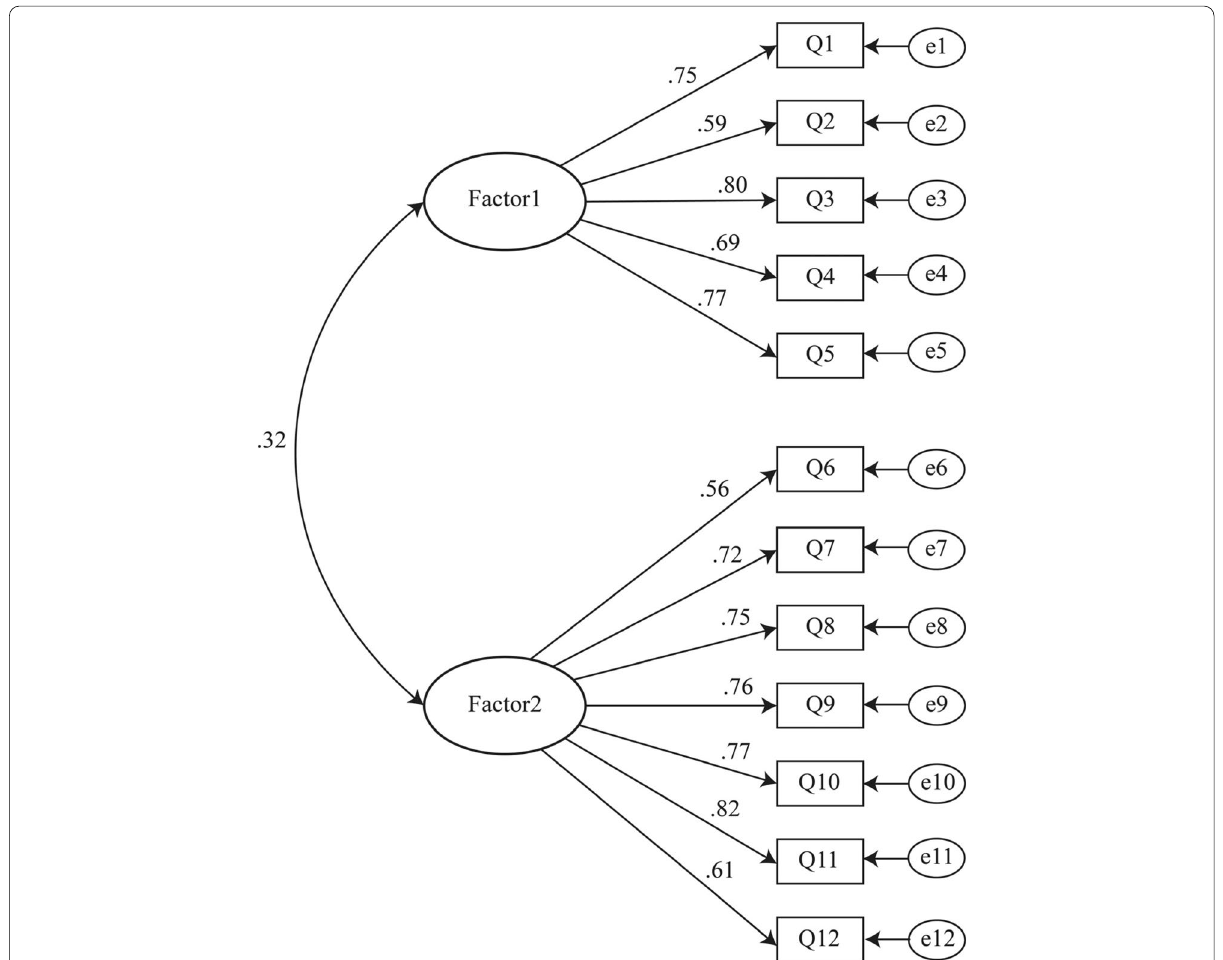
Fig. 1 Standardized coefficient model of